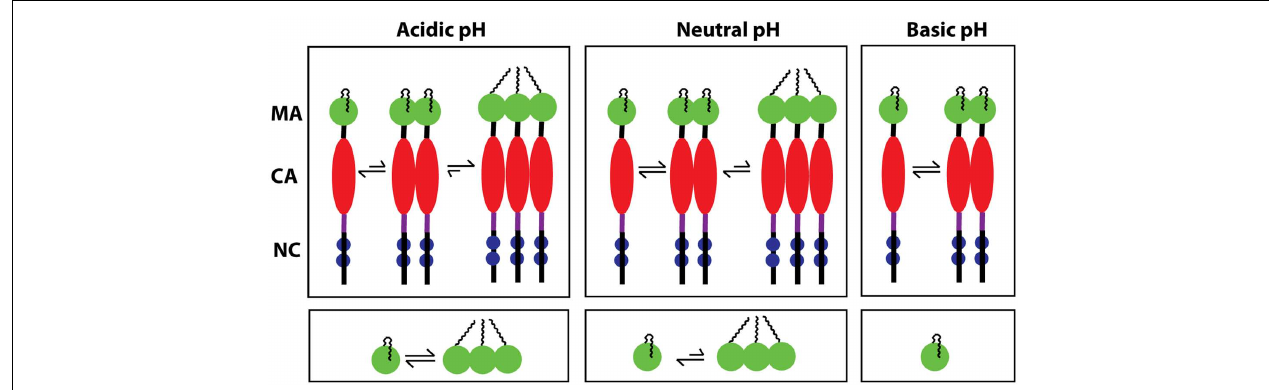
FIGURE 3 | Schematic representation showing multimerization events of Gag and MA proteins as a function of pH. Reprinted with permission from (Fledderman et al., 2010). Copyright {2010} American Chemical